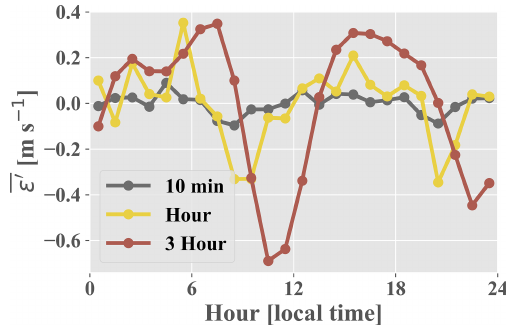
Figure B2. Average exogenous error ( ε (cid:48) ) produced by the BCA partitioned by hour of the